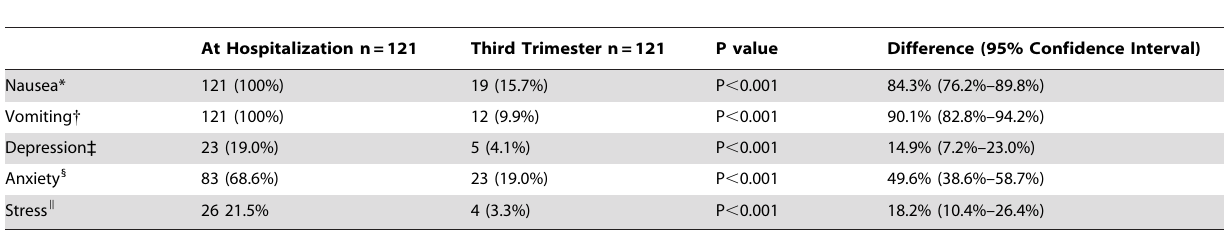
Table 2. Comparison of Nausea, Vomiting, Depression, Anxiety and Stress at Hospitalization for Hyperemesis Gravidarum and at the Third Trimester.